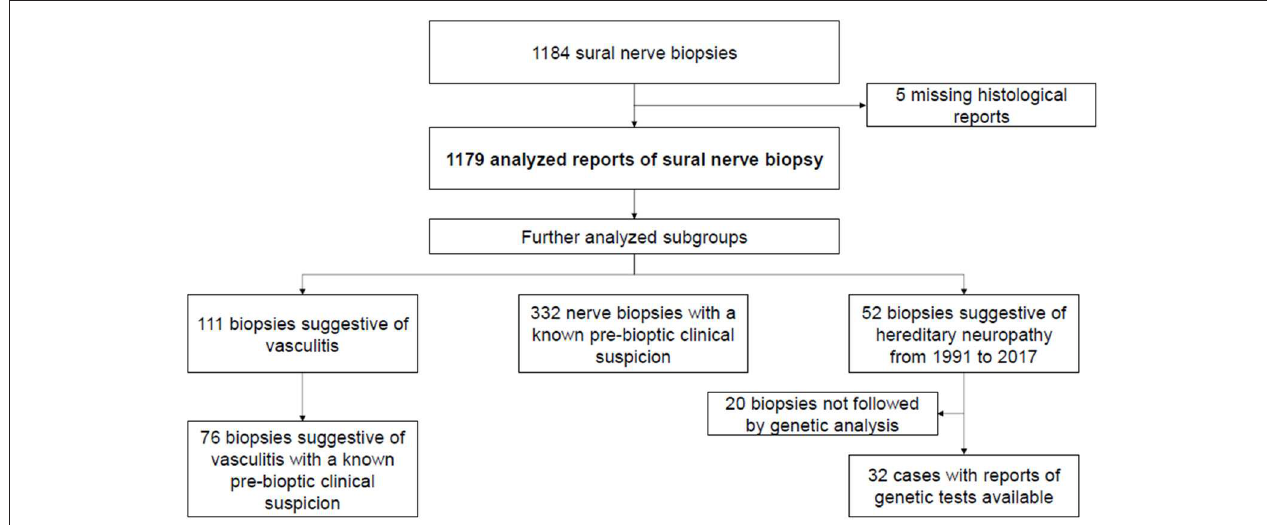
FIGURE 1 | Selection criteria.